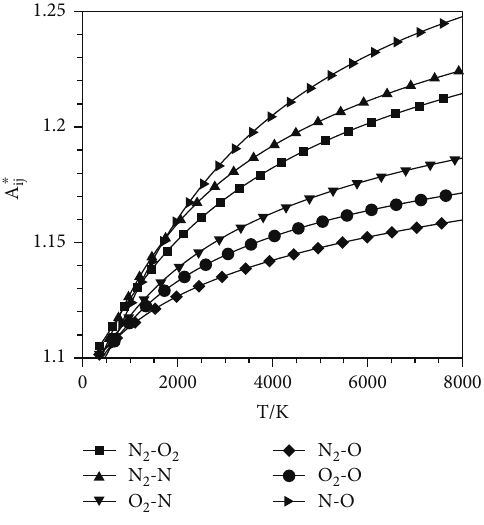
Figure 6: A ∗ ij between neutral species.